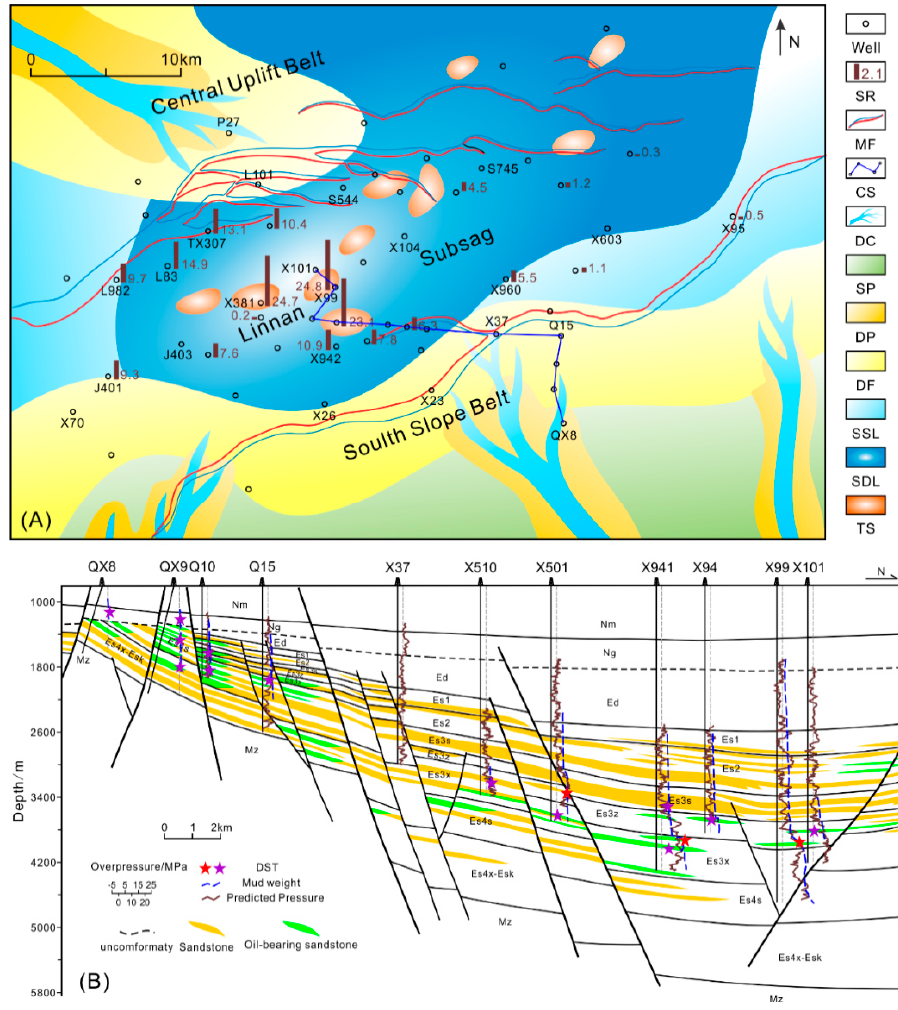
Figure 15. ( A ) Distribution of the reservoir pressure superposed with sedimentary facies in the Linnan Sag (the sedimentary facies are modified from [75]). SR = measured reservoir pressure, MF = major fault, CS = cross section, DC = distributary channel, SP = swamp, DP = delta plain, DF = delta front, SSL = shore shallow lacustrine, SD = semi-deep and deep lacustrine, TS = turbidite sandstone. ( B ) The distribution of reservoir pressure and mudstone pressure in a cross section in the Linnan Sag shows the complex characteristics of the pressure systems (the sandstone and fault interpretations are modified from [75]). Purple stars are normal pressured sandstones in hydrostatic environment, or are laterally continuous or connected by faults, red stars refer to isolated overpressured sand bodies.